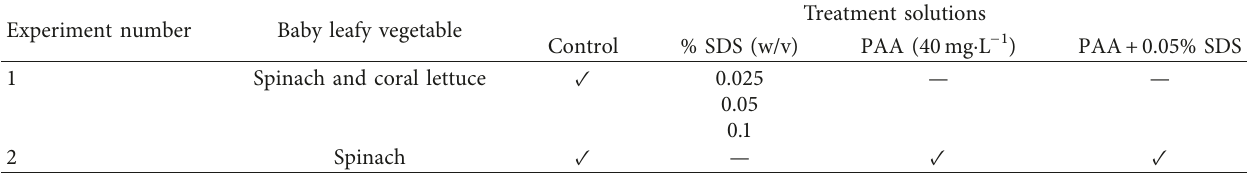
Table 1: Details of variety of leafy salad vegetables and concentrations of surfactant and sanitiser solutions used for experiments 1 and 2. Experiment